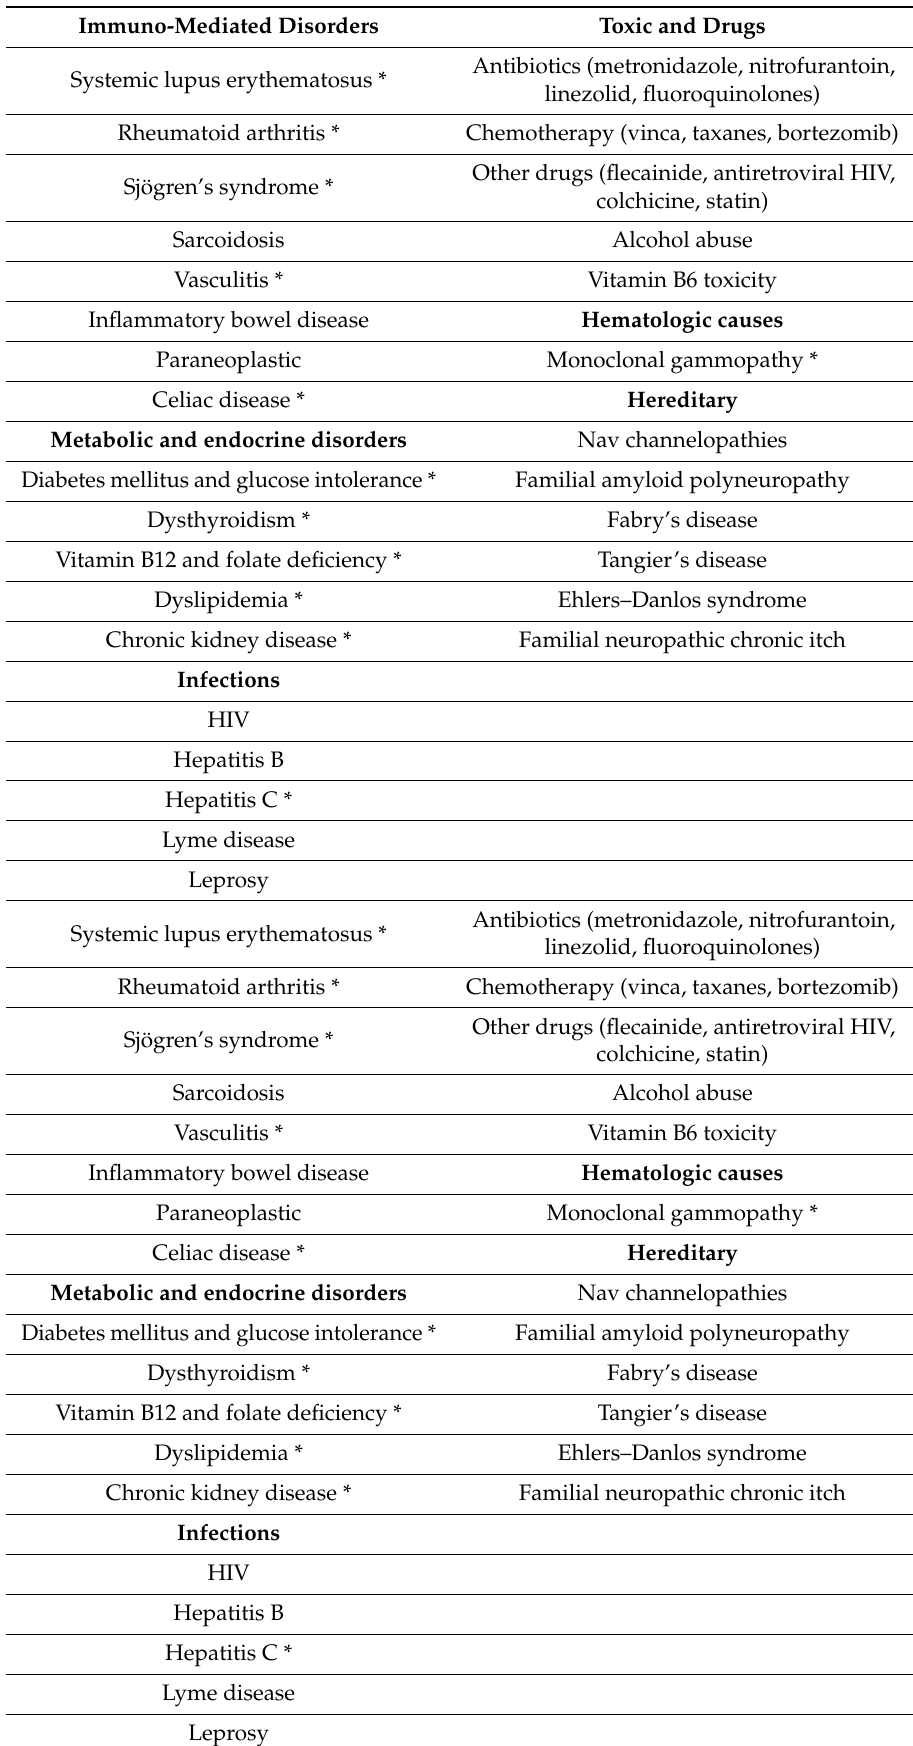
Table 1. Causes of small fiber neuropathy